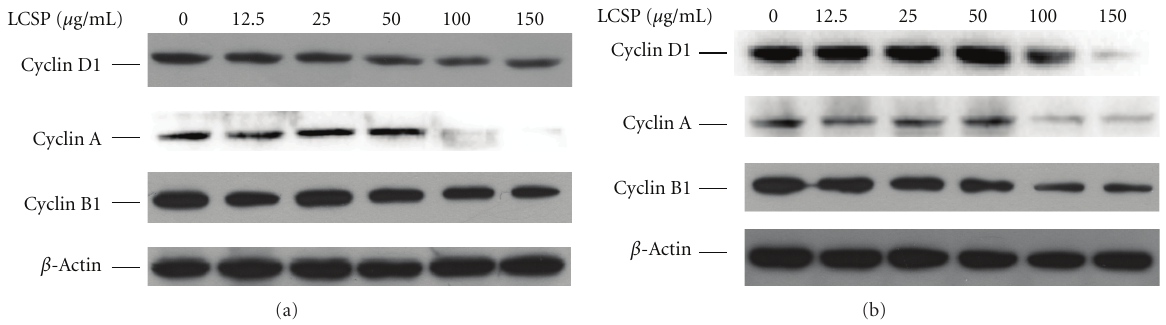
Figure 3: Immunoblots of cell cycle-controlling proteins in LCSP-treated CRC cells. Cells were treated with increasing concentrations of LCSP as indicated and then incubated at 37 ◦ C for 24h. Cell protein lysates from Colo320DM (a) and SW480 (b) cells were separated by SDS-PAGE, transferred to PVDF membranes, and immunoblotted to show cyclin D1, cyclin A, and cyclin B1 levels, and the beta-actin level as a loading